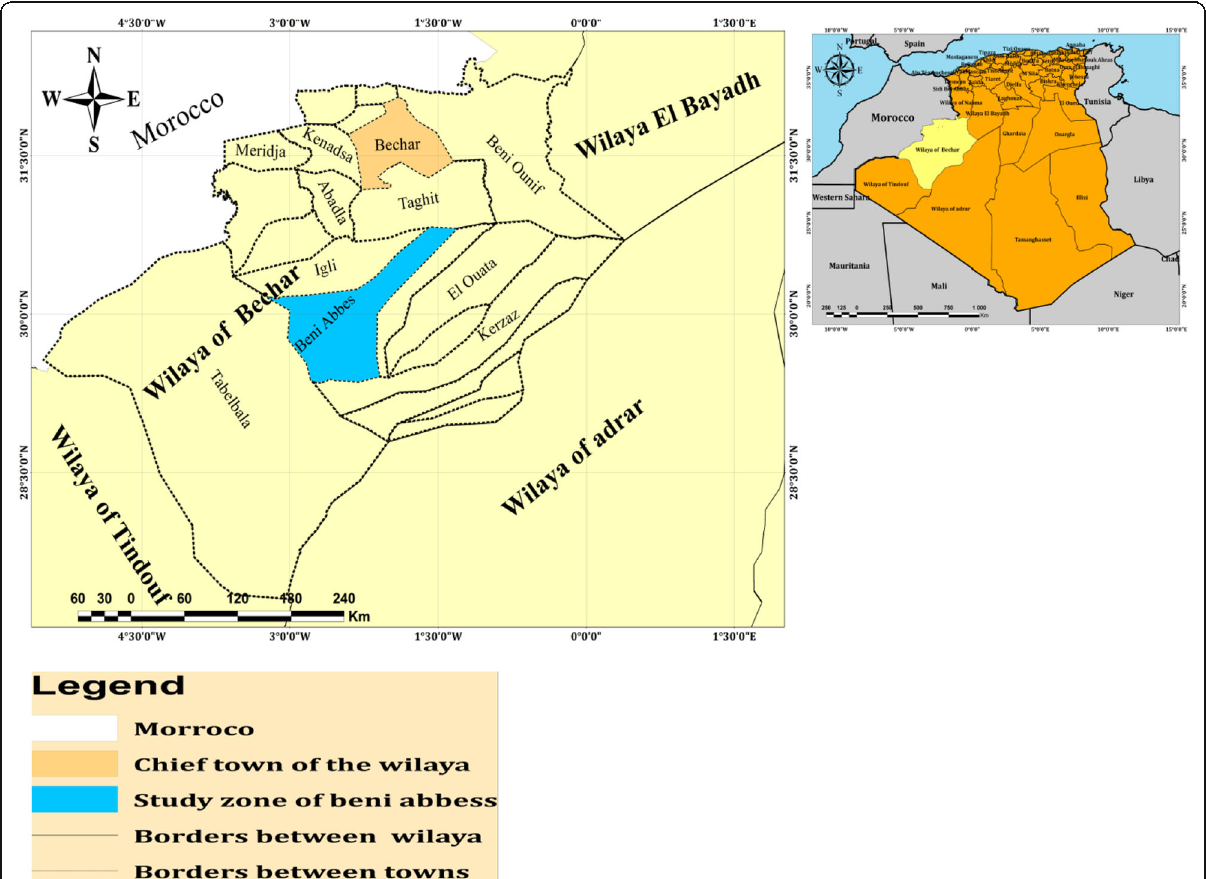
Fig. 1 Location map of the Béni Abbés